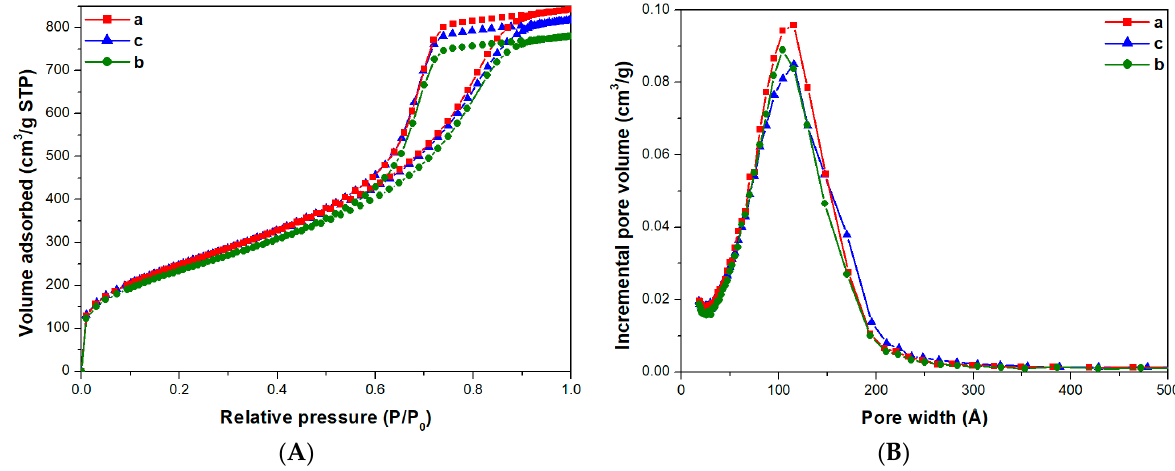
Figure 2. N 2 adsorption and desorption isotherms at 77K ( A ) and pores size distribution ( B ) of calcined Mono-ICE-Lateral A (a), Mono-ICE-Lateral B (b), and Mono-ICE-Central C (c).